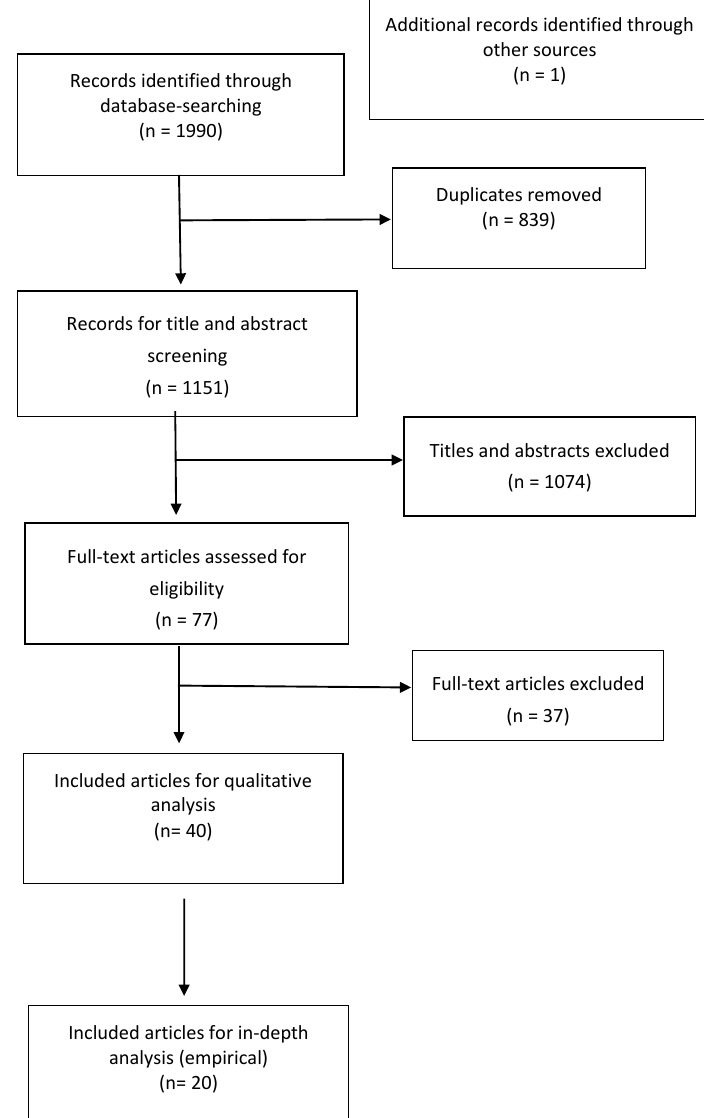
Figure 2. Flowchart of search strategy for literature review.